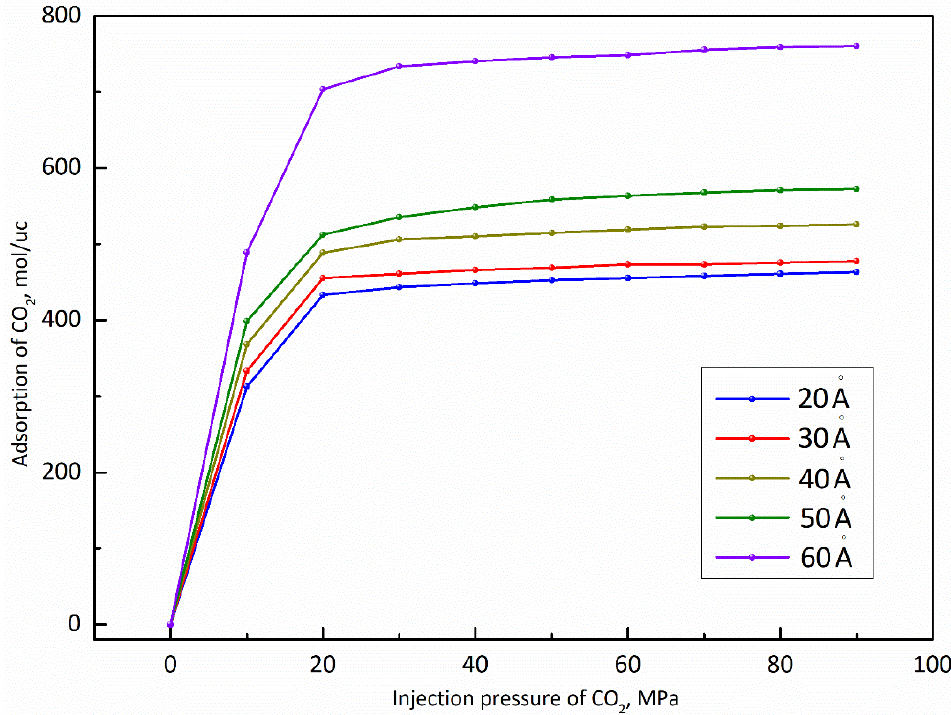
Figure 6. The molar quantity of CO 2 absorbed in the pores of different sizes under different injection pressure.